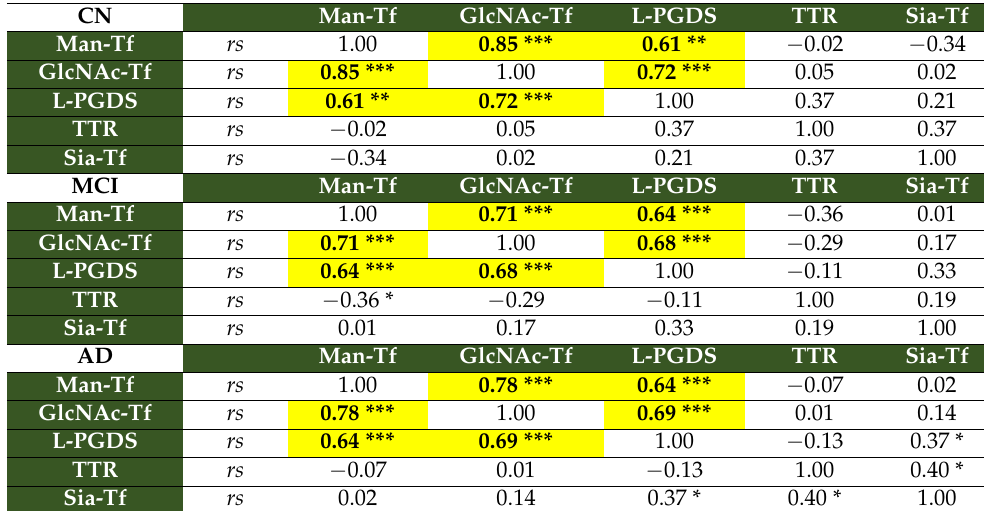
Sia-Tf rs 0.40 * 1.00 Spearman’s rank correlation coefficients ( rs ) with values higher than 0.50 are highlighted with bold letters in yellow cells. Man-Tf data of MCI and AD are cited from our previous paper [15]. Probability levels: * p < 0.05, ** p < 0.01, *** p <